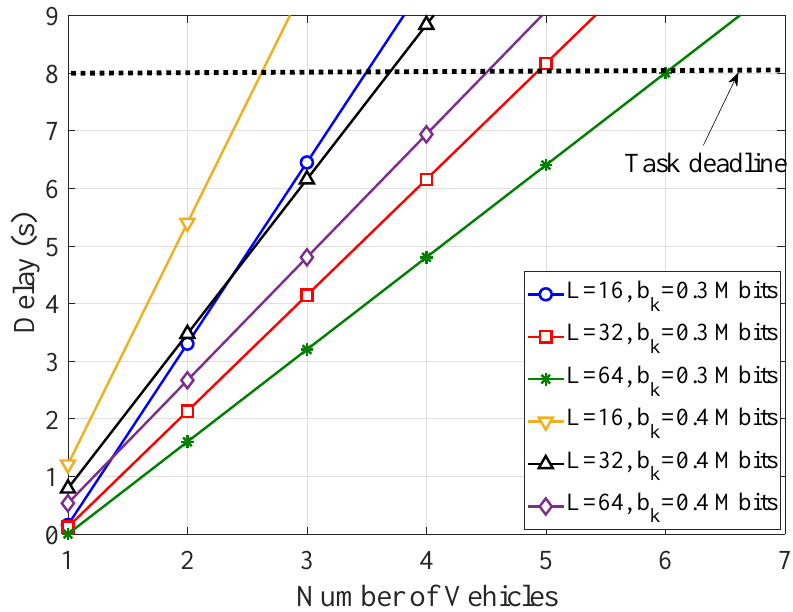
Figure 3. The total computation-based and communication-based delay (TCCD) as a function of the number of vehicles for different numbers of reflecting elements and task requirements.